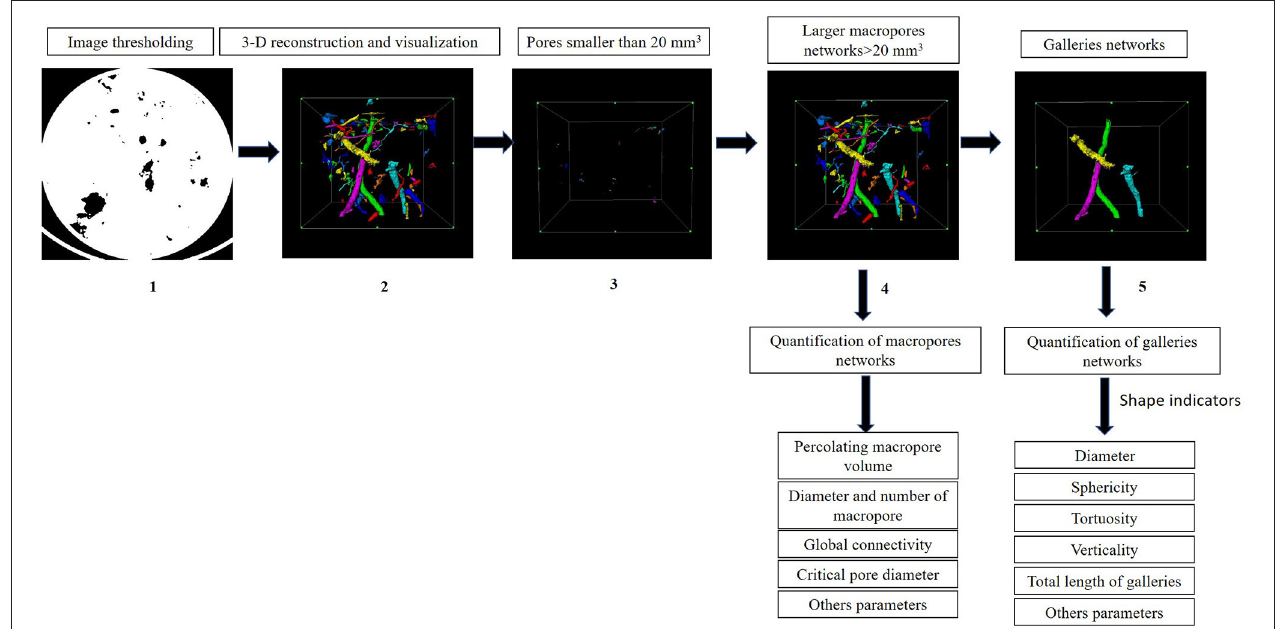
FIGURE 1 | Procedure used for image analysis and quantification of macropores below soil macrofauna biostructures and the differentiation of macropores and galleries. (1) Segmentation of the image. (2) Reconstruction and visualization of the total macroporosity. (3) Representation of the pores < 20 mm 3 that were discarded to reduce noise. (4) Representation of macropores > 20 mm 3 . (5) Galleries manually isolated from macropores.